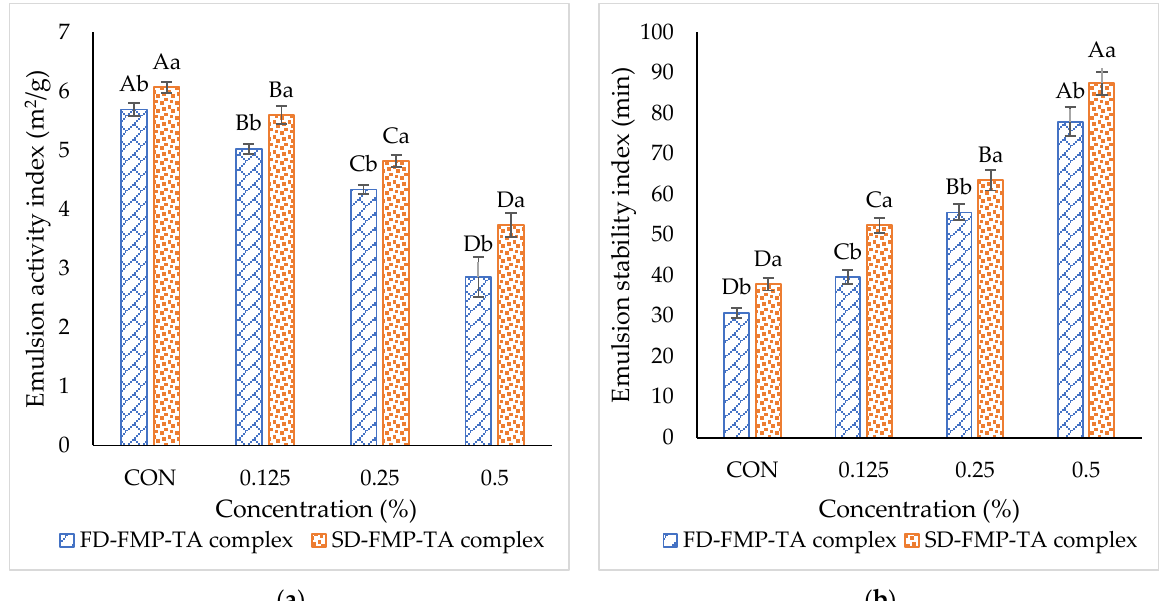
Figure 4. ( a ) Emulsion activity index (EAI) and ( b ) emulsion stability index (ESI) of emulsions stabilized by freeze-dried (FD) and spray-dried (SD) fish myofibrillar proteins (FMP) modified with tannic acid (TA) at varying concentrations. Different uppercase letters on the bars within the same sample denote significant differences ( p < 0.05). Different lowercase letters on the bars within the same concentration of the FMP-TA complex denote significant differences ( p < 0.05). Error bars represent standard deviation (n = 3).